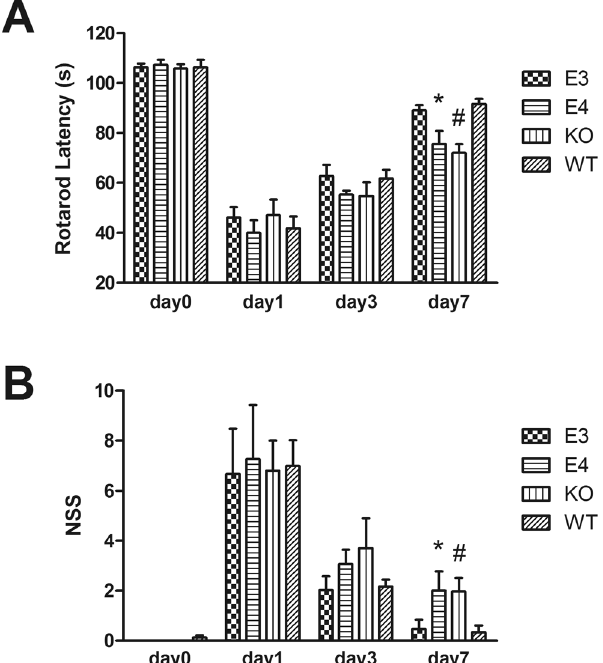
Figure 2. Neurobehavioral status after CCI was evaluated by the Rotarod and NSS methods. Obvious neurological deficits were observed at day 1 and day 3 after TBI. However, at day 7, the WT mice recovered significantly more than the E4 and KO mice, and the E3 mice recovered faster than the E4 mice. ( * P < 0.05 vs E3 mice and WT mice; # P < 0.01 vs WT mice. N = 8). The data are presented as the mean ± SD.